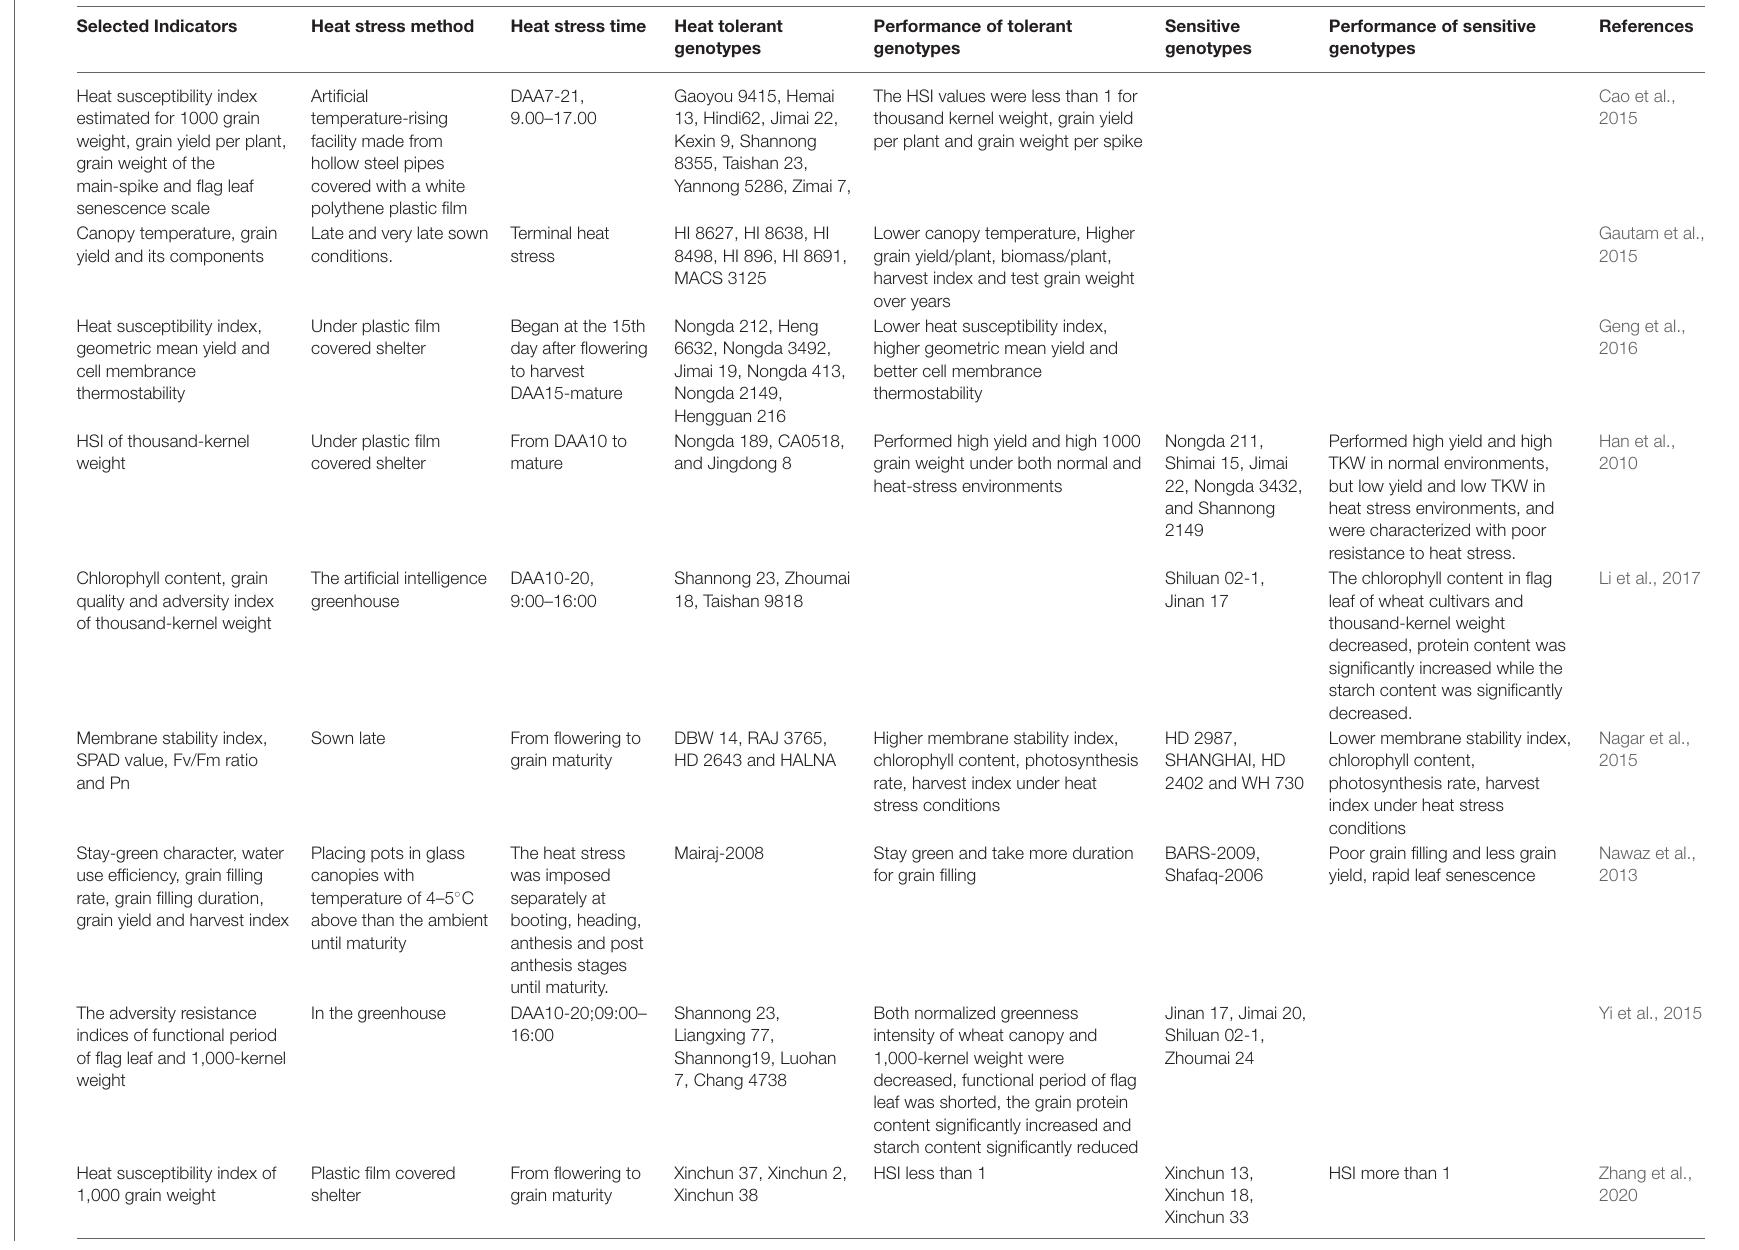
TABLE 3 | Heat-tolerant and heat-sensitive wheat genotypes and the selected indicators and performance to high-temperature